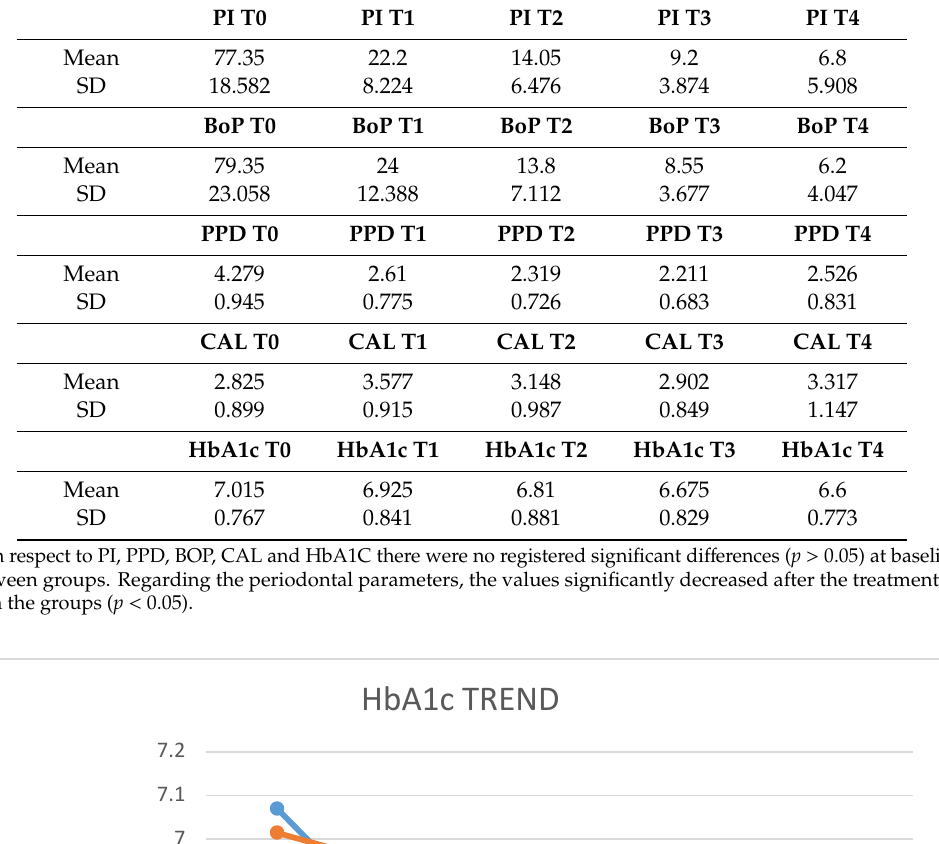
Table 1. Clinical data about the control group.